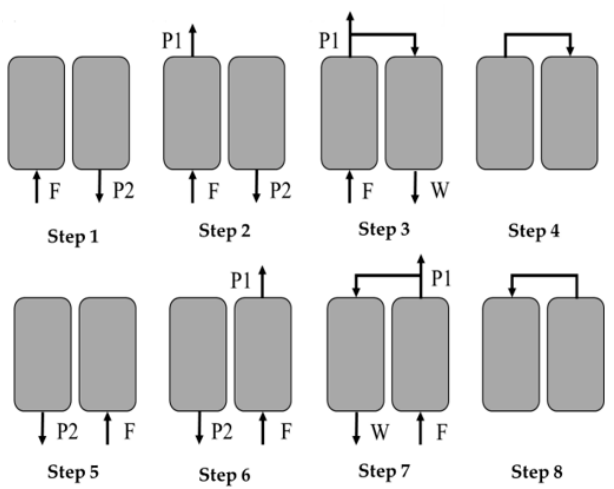
Figure 4. Schematic diagram of the dual-bed eight-step process: F, feed; P1, top product; P2, bottom product; W, waste. Table 5. Steps of the dual-bed eight-step process.